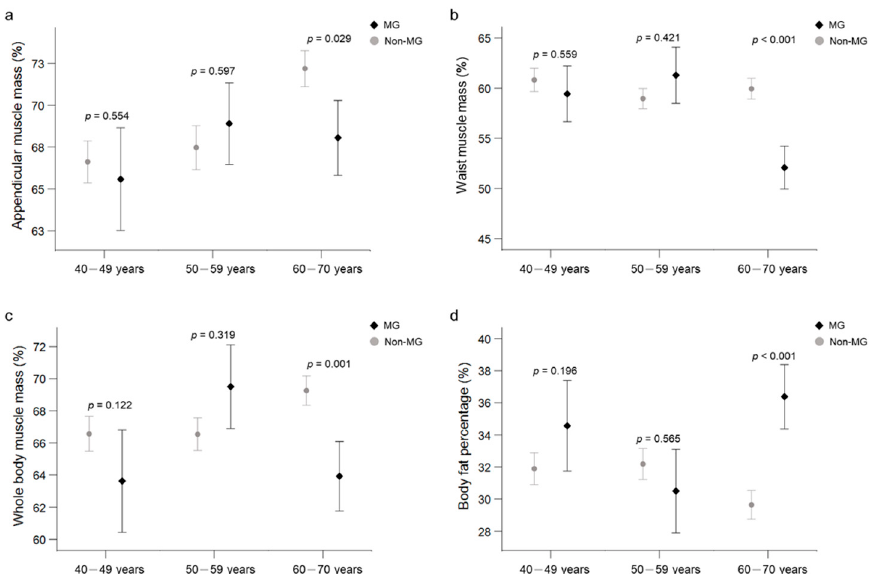
Figure 1. Trend toward lower body muscle mass percentages and higher body fat adiposity in the MG group, particularly regarding appendicular ( a ), waist ( b ), whole body ( c ) muscle mass percentages and body fat percentage ( d ) in the older subgroup. MG, myasthenia gravis group; Non-MG, control groups. Table 3. Body composition in MG and sex- and age-matched controls aged 60–70 years.